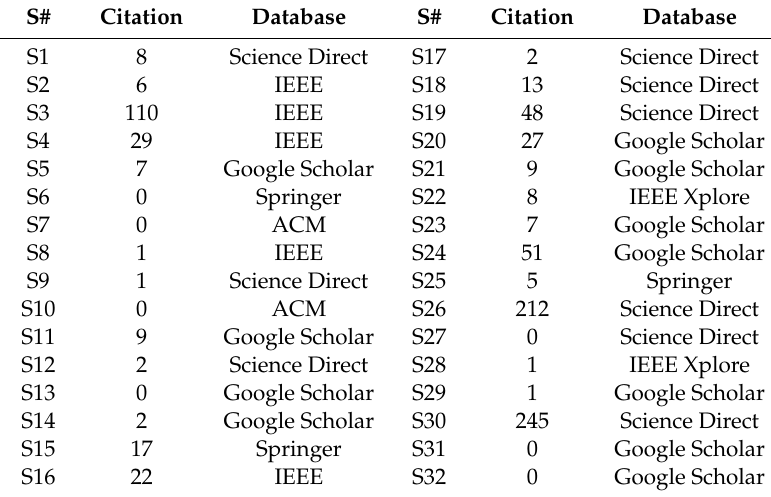
Table 8. Citation of selected Deep Learning and Machine Learning Papers.